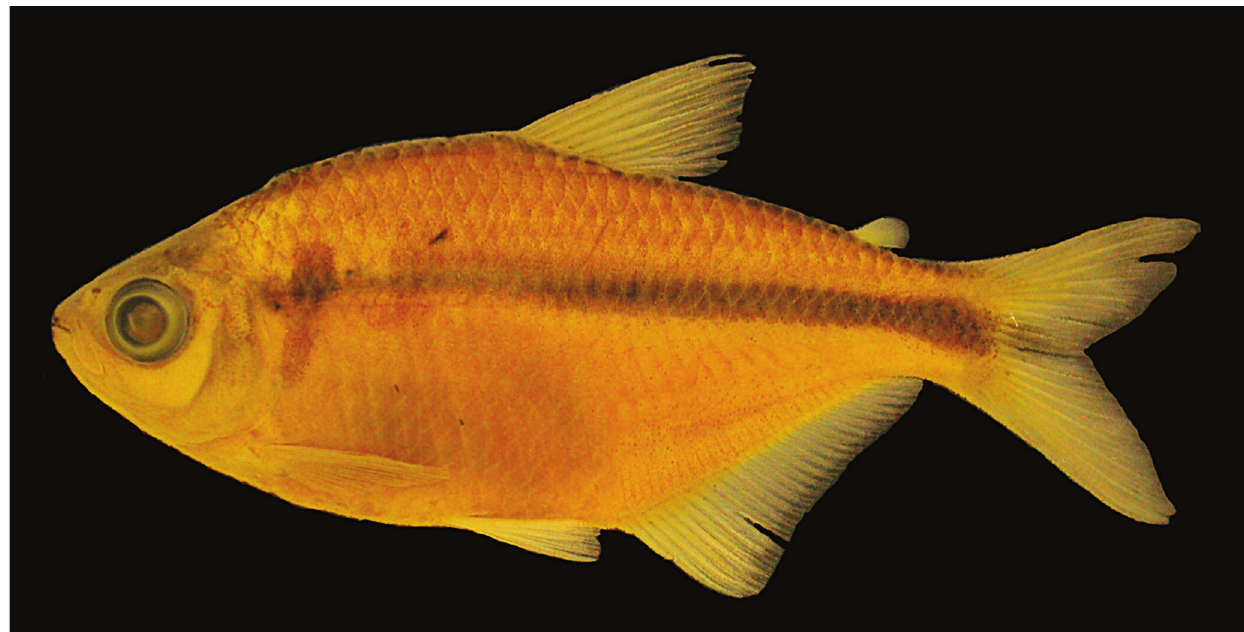
Fig. 1. Astyanax dissensus , new species, MCP 47000, 65.1 mm SL, holotype, arroio Candiota, rio Jaguarão drainage, Candiota, Rio Grande do Sul,